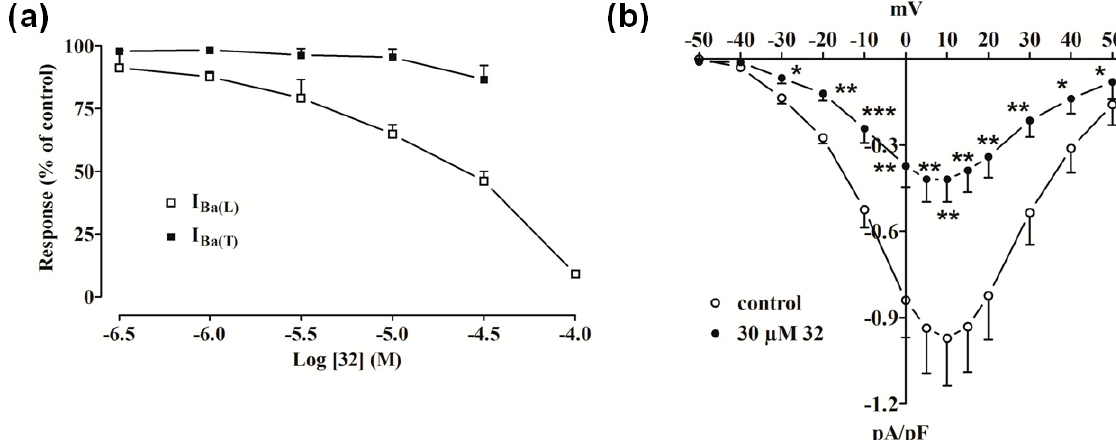
Figure 2. Effect of compound 32 on I Ba in single tail artery myocytes. ( a ) Concentration-dependent effect of 32 at the peak of I Ba(L) and I Ba(T) trace. On the ordinate scale, response is reported as percentage of control. Data points are mean ± SEM (n = 3–6); ( b ) Current-voltage relationships, recorded from a V h of –80 mV, constructed prior to the addition (control) and in the presence of 30 µM 32 . Data points are mean ± SEM (n = 6). * p < 0.05, ** p < 0.01, *** p < 0.001 vs. control, Student’s t test for paired